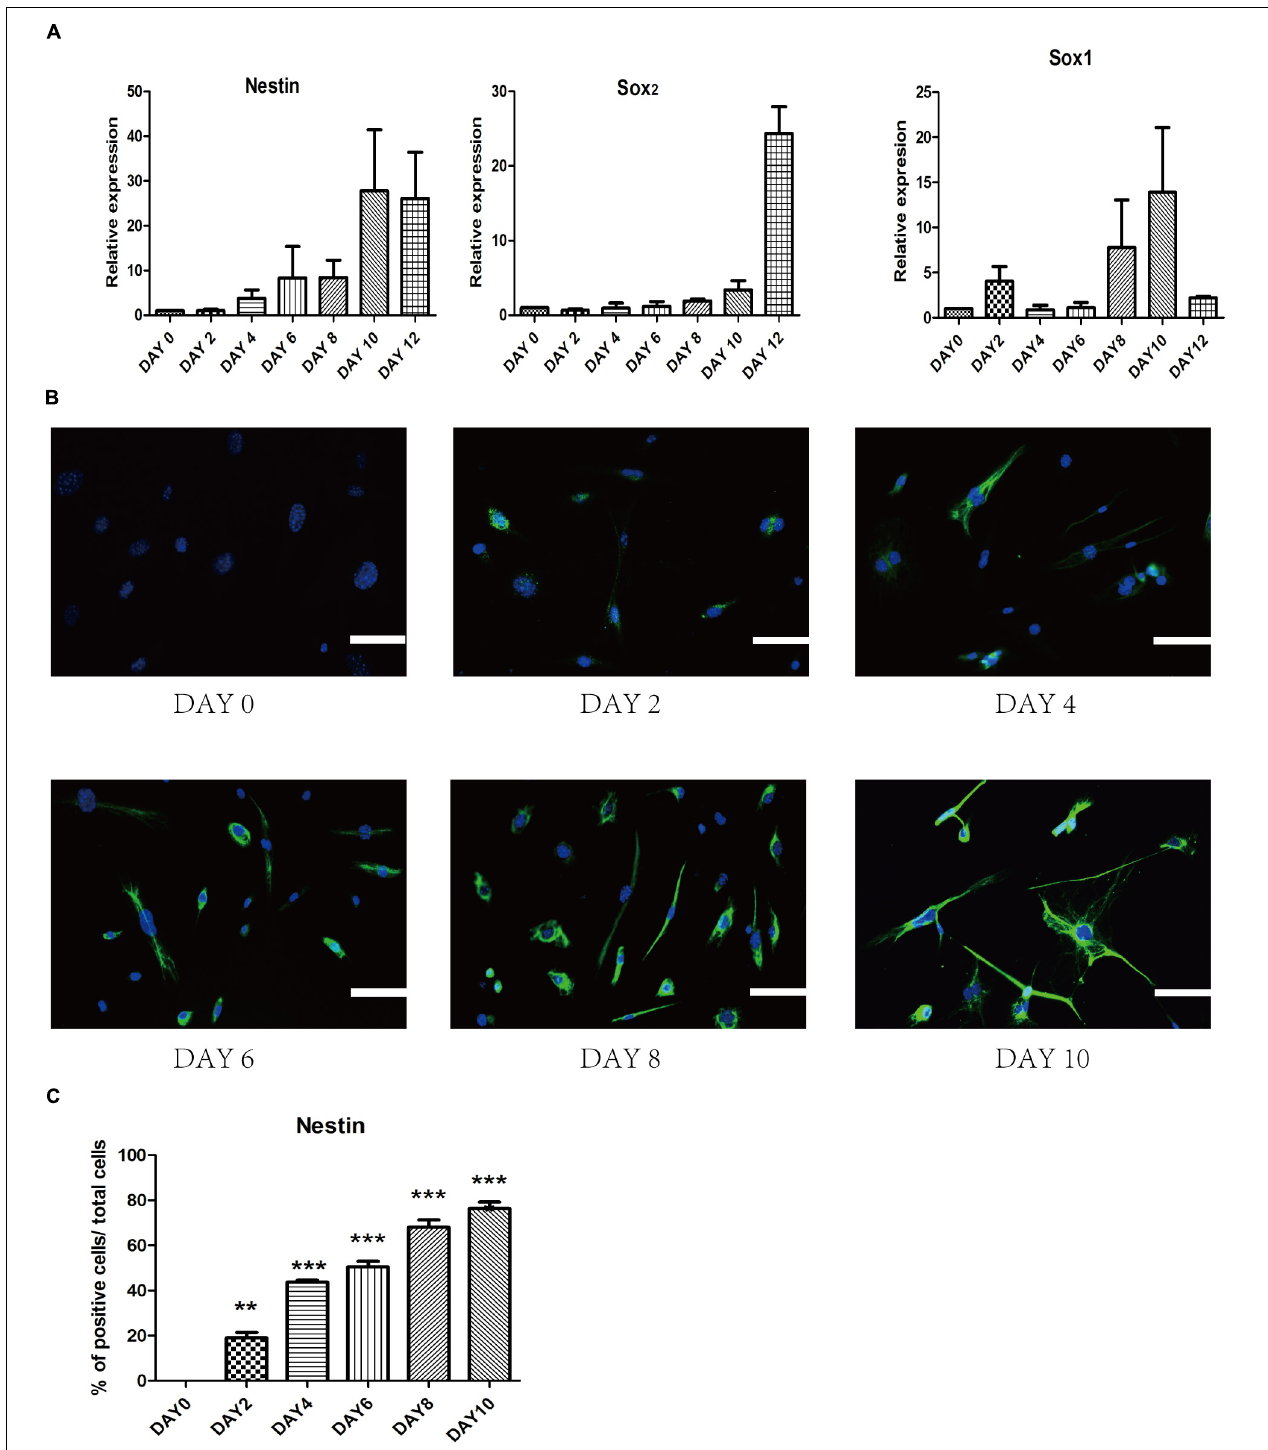
FIGURE 5 | Change of endogenous relative transcription factors and expression of epigenetic analyses during the induced process. (A) qRT-PCR analyses of NSC markers (Nestin, Sox2, and Sox1) during the reprogramming stages. Glyceraldehyde 3-phosphate dehydrogenase (GAPDH) was used as a loading control. (B) Immunostaining of Nestin (Green) was detected every 2 days in the induced process. Nuclei were counterstained with DAPI (blue). (C) Quantitative analyses of the protein expression level of Nestin. Data represent the mean ± SEM. F = 97.68 ∗∗ p < 0.01, ∗∗∗ p < 0.001 compared with day 0; One-way ANOVA followed with Dunnett’s T3 test. Scale bars: 100 µ